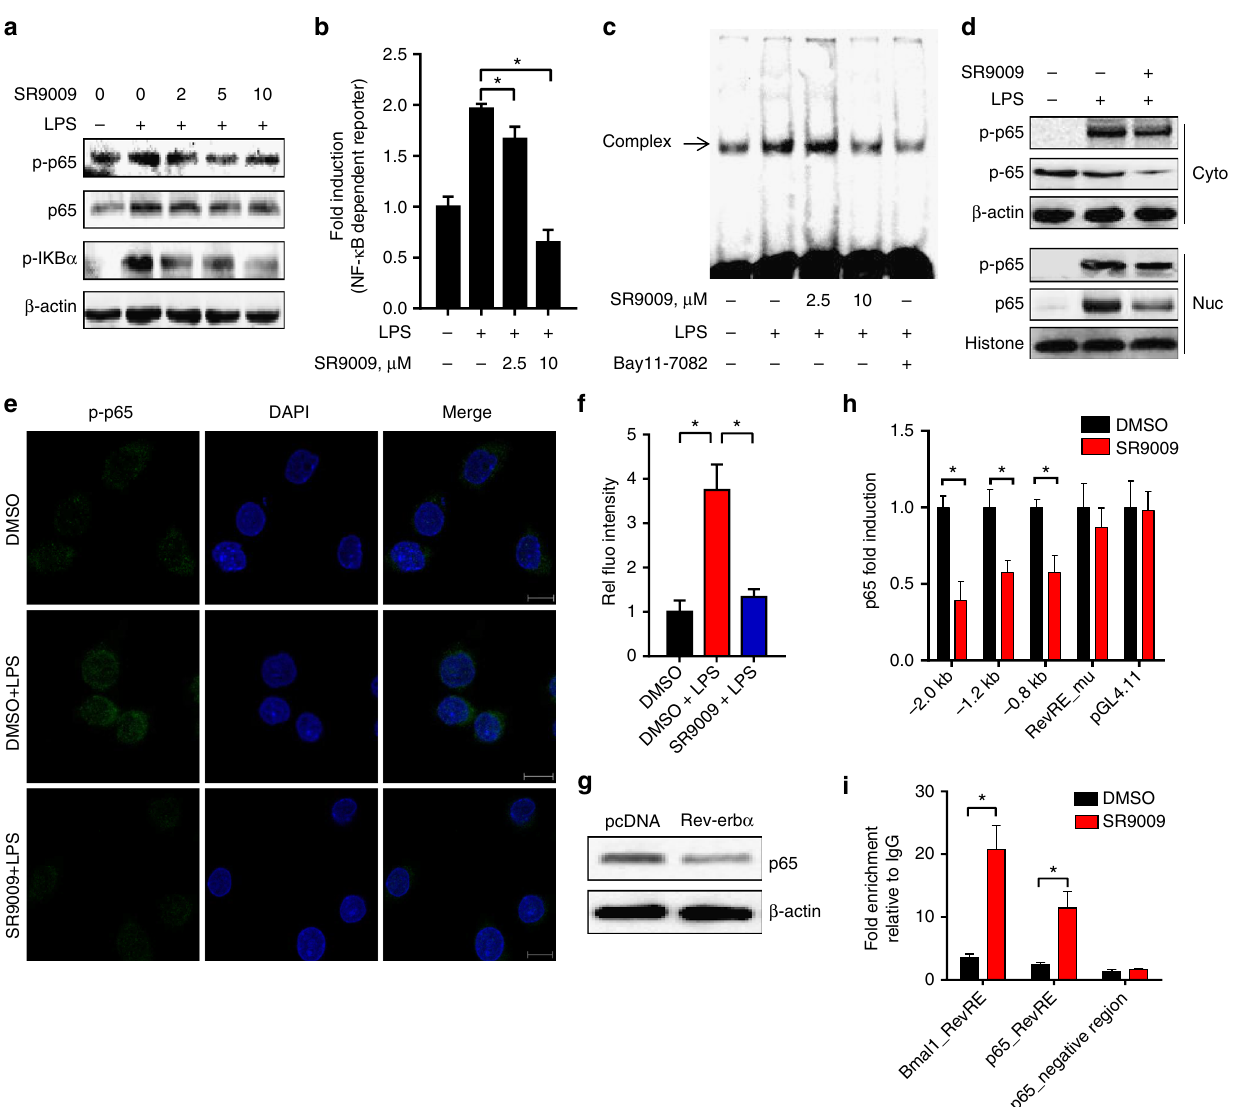
Fig. 6 Rev-erb α activation inhibits NF- κ B signaling and p65 transcription. a Protein expressions of p65, p-p65, and p-IKB α in Raw264.7 cells measured by western blotting. Cells were pretreated with indicated concentrations of SR9009 or vehicle for 1 h and then stimulated with LPS for 12 h. b Luciferase reporter assays with Raw264.7 cells, showing Rev-erb α -dependent activation of NF- κ B pathway. Cells were transfected with the NF- κ B-dependent reporter (containing four κ B sites) followed by treatment with SR9009 or vehicle for 1 h and stimulated with LPS for 8 h. Data are mean ± SD ( n = 6). * P < 0.05 versus the group treated with LPS alone ( t test). c EMSA assays performed with biotin-labeled NF- κ B probe (containing NF- κ B consensus binding sequence) in the presence of nuclear extracts. Raw264.7 cells were pretreated with Bay11-7082 (10 μ M) or SR9009 for 1 h and then stimulated with LPS for 8 h. d Protein expressions of p65, p-p65, β -actin, and Histone H3 in cytoplasm (Cyto) or nucleus (Nuc) of Raw264.7 cells measured by western blotting. Cells were pretreated with SR9009 or vehicle for 1 h and then stimulated with LPS for 12 h. e Immuno fl uorescence analysis of p-p65 localization. Scale bar = 10 µ m. f Intensity levels of green fl uorescence for p-p65 quanti fi ed in six different fi elds. Data are mean ± SD ( n = 6). g Effects of Rev-erb α overexpression on p65 protein in Raw264.7 cells. Each western blot is representative of three independent experiments (statistical differences between blot density levels were analyzed by Mann – Whitney U test, Supplementary Figure 12). h Luciferase reporter assays in Raw264.7 cells with distinct p65 promoter reporters. Cells were transfected with blank PGL4.11 and p65 reporter [ − 2.0 kb, − 1.2 kb, − 0.8 bp, or RevRE ( − 474/ − 484 bp)_mutant], followed by treatment with SR9009 or vehicle for 1 h and stimulation with LPS for 8 h. Data are mean ± SD ( n = 6). i ChIP assay with PMs, showing recruitment of Rev-erb α to Bmal1 or p65 promoter. PMs were treated with SR9009 or vehicle. Data are mean ± SD ( n = 4). In panels f , h and i , * P < 0.05 ( t test or Mann – Whitney U test). Concentrations of SR9009, LPS, and ATP for cell treatment were 10 μ M, 100 ng/ml, and 2 mM,